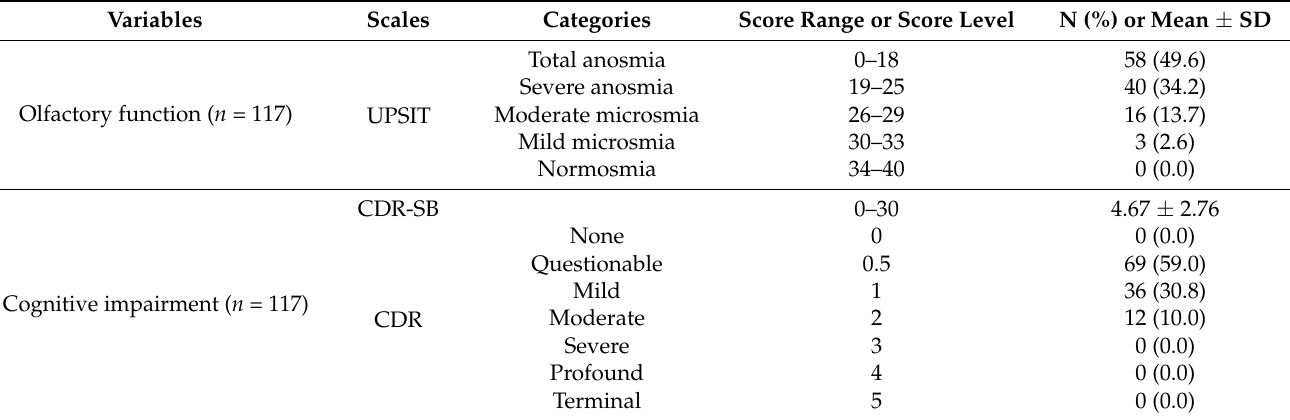
Table 2. Participants’ olfactory function and cognitive impairment.